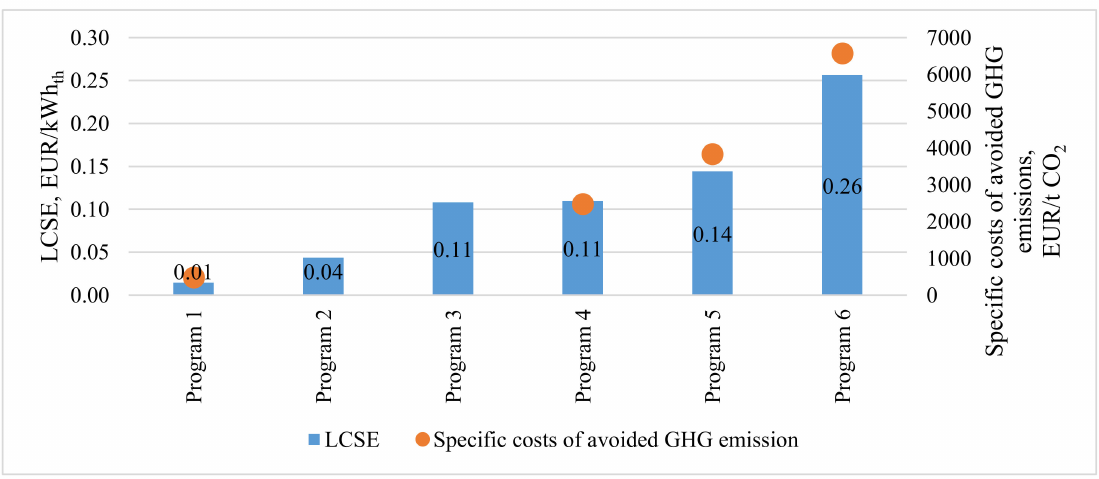
Figure 5. Specific costs for energy savings and specific costs of avoided green-house gas (GHG) emissions of di ff erent energy e ffi ciency